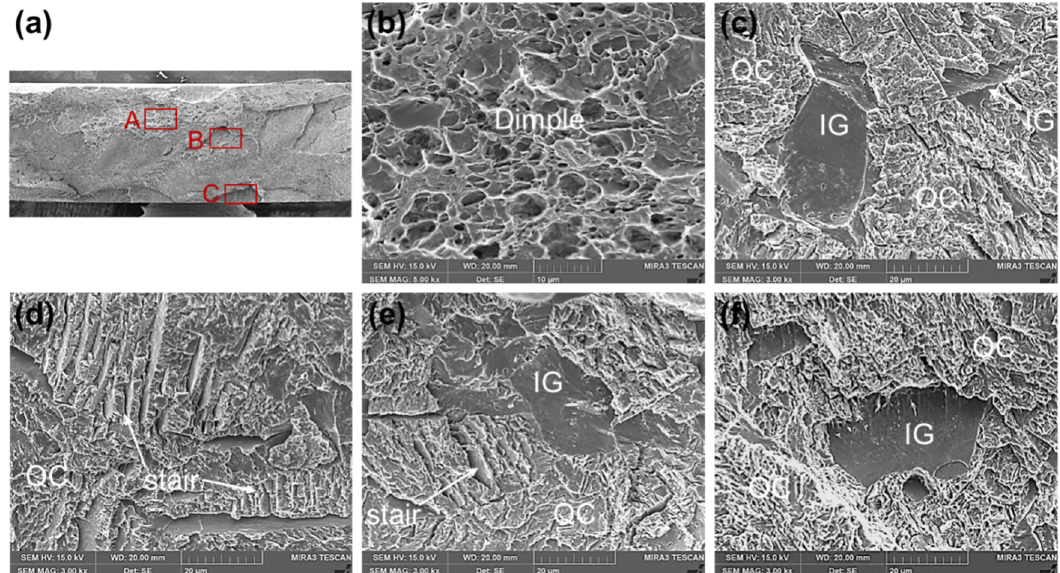
Figure 7. FE–SEM fractographs of the WJs after in situ SSRT: ( a ) overview of the fractured surface and ( b – f ) magnified fractographs of the red boxes shown in Figure 7a: ( b ) DF at A, ( c ) AF at B, ( d , f ) DF at C, ( e ) AF at C.